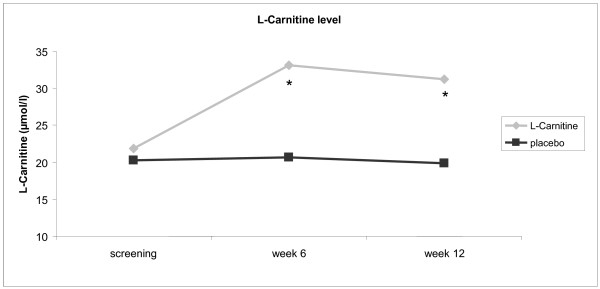
Reasons for discontinued convention of the study patients.